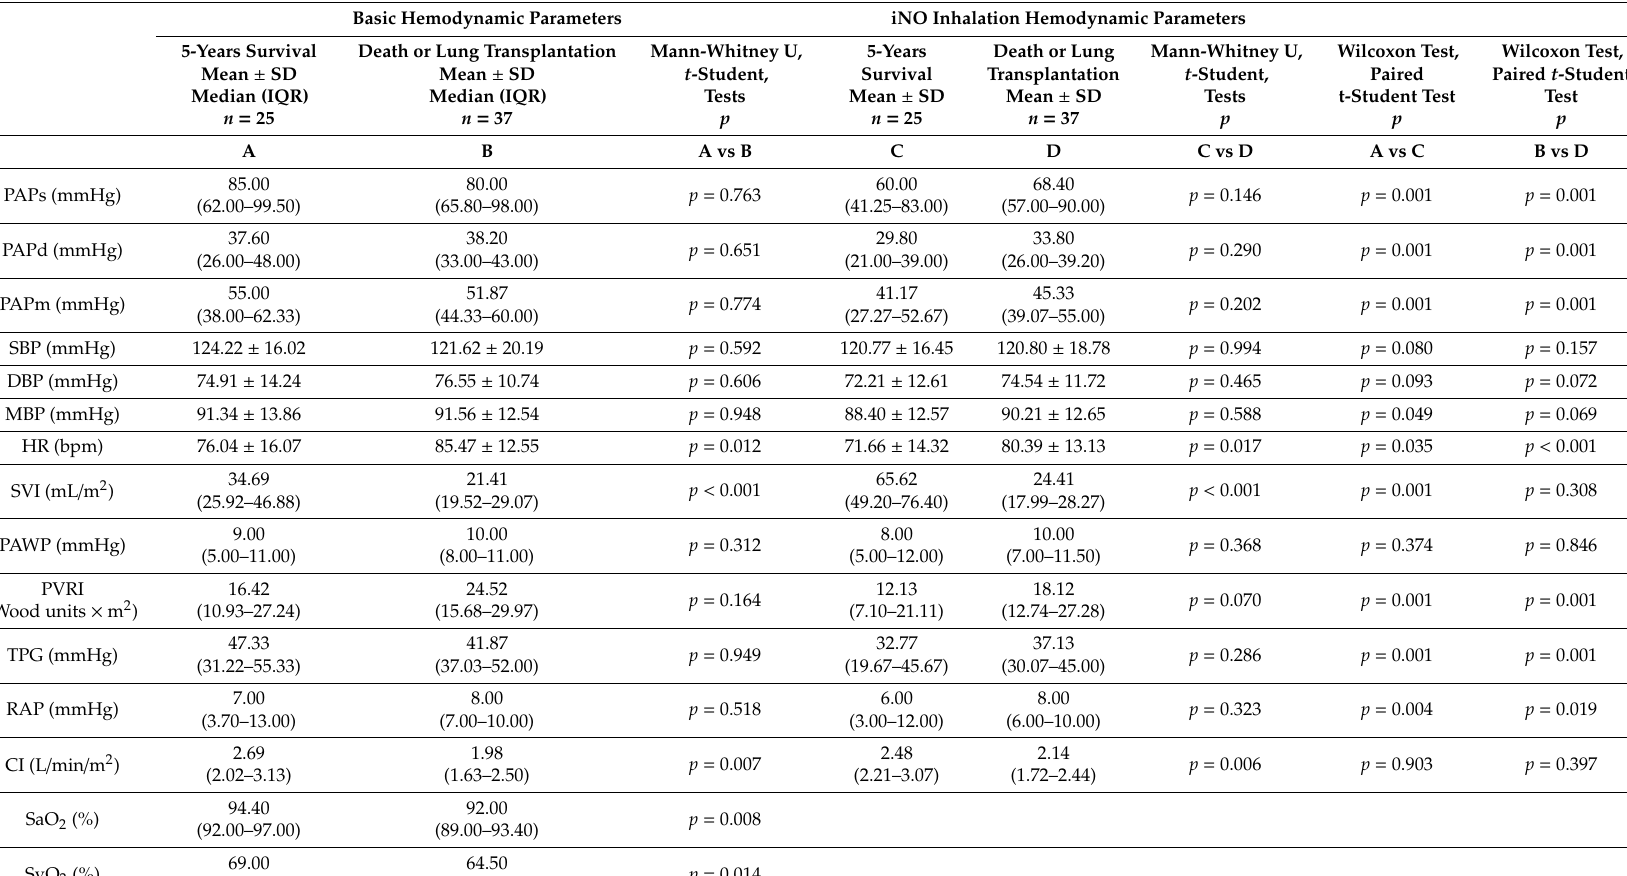
Table 3. Hemodynamic characteristic of subgroups depending on the prognosis in the five-year